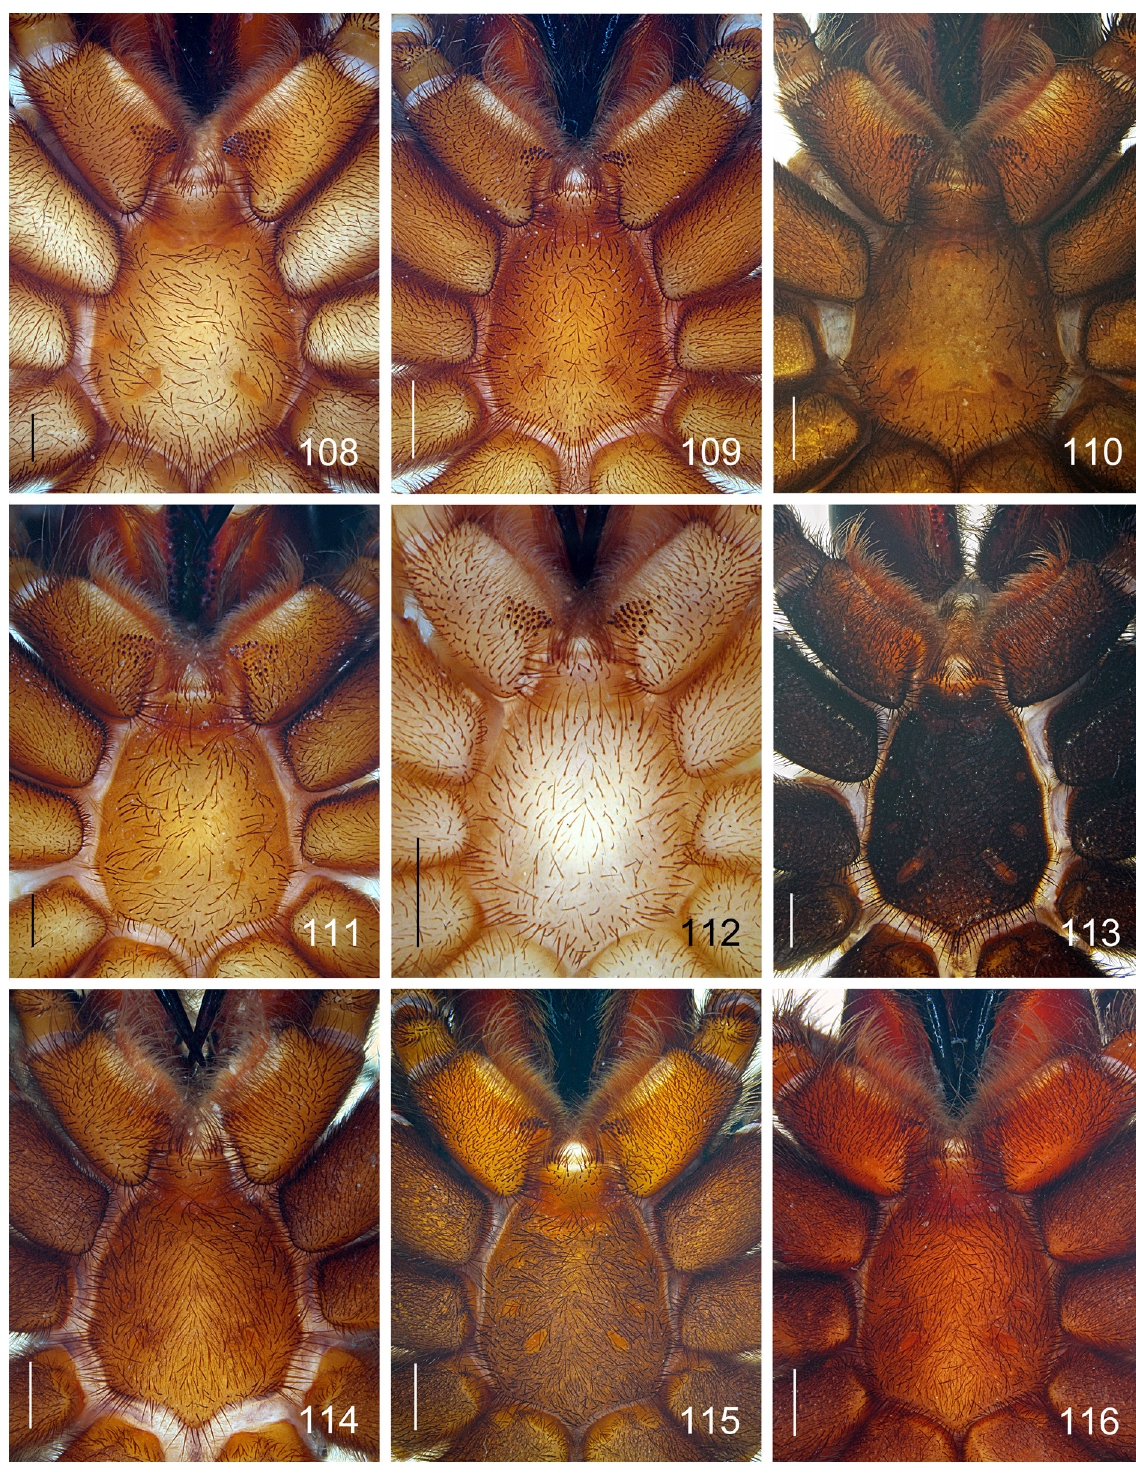
Figs 108–116. Anemesia spp., ♀♀, sternum, labium and maxillae, ventral views. 108 . A. oxiana sp. nov. (paratype, Hojamaston). 109 . A. sogdiana sp. nov. (paratype, Amankutan Pass). 110 . A. castanea sp. nov. (Ganjina). 111 . A. karatauvi (Andreeva, 1968) (paratype, Hojamaston). 112 . A. pallida sp. nov. (paratype, Ganjina). 113 . A. incana Zonstein, 2001 (paratype). 114 . A. infumata sp. nov. (paratype). 115–116 . A. infuscata sp. nov. (paratypes, Varzob and Sanglok Mts, respectively). Scale bars: 1.0